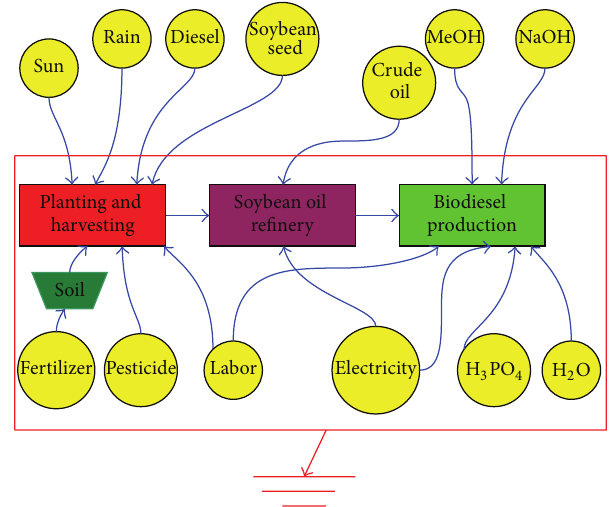
Figure 5: Emergy flow diagram of soybean-based biodiesel produc- tion